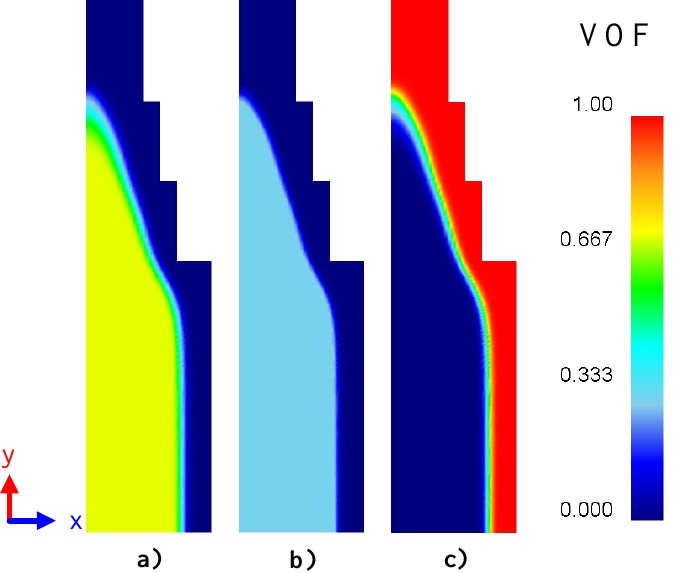
Figure 5. Cloud diagram of microstructure distribution before spray cooling. ( a ) Pearlite; ( b ) bainite; ( c ) austenite.